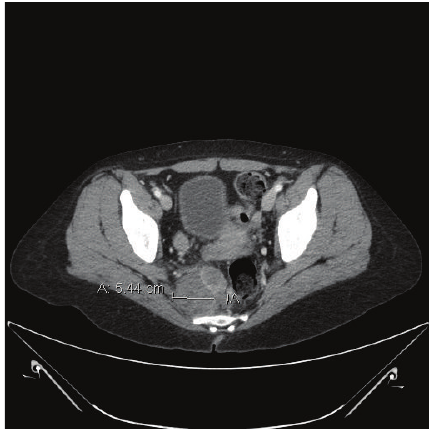
Figure 1: CT scan of the pelvis at the level of the iliac crest reveals a 5.4 cm soft tissue mass. Bones of the pelvis demonstrate abnormal texture.